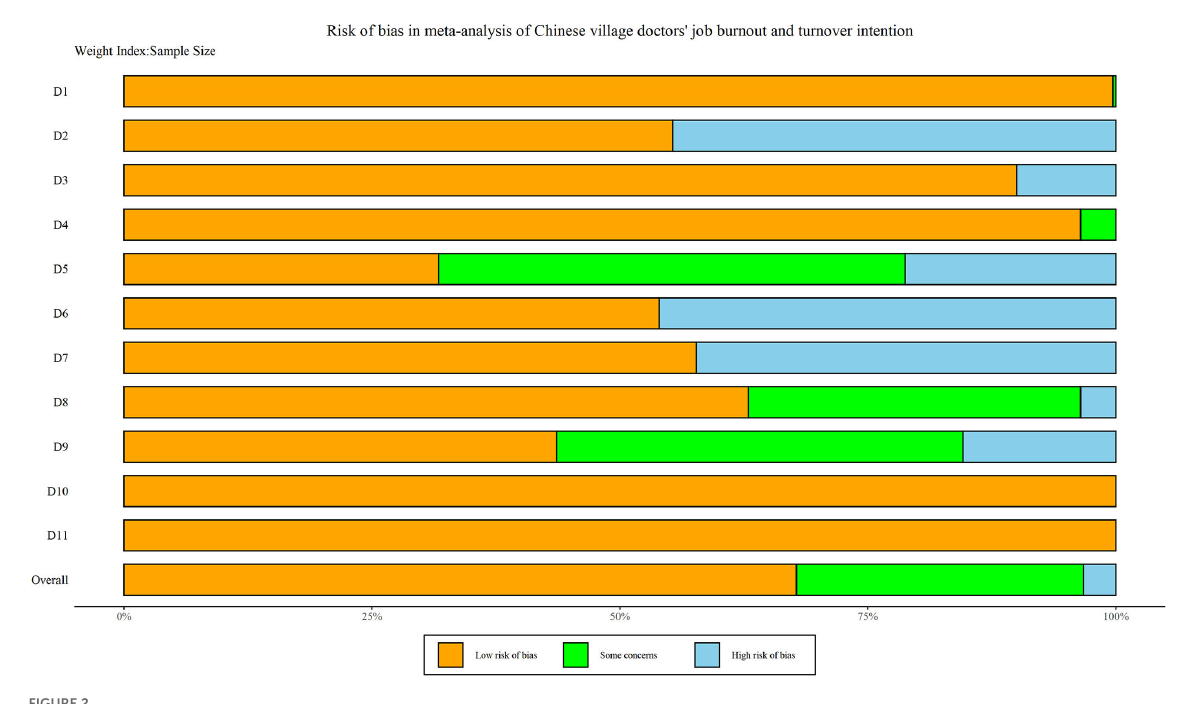
FIGURE2 A summary plot of risk